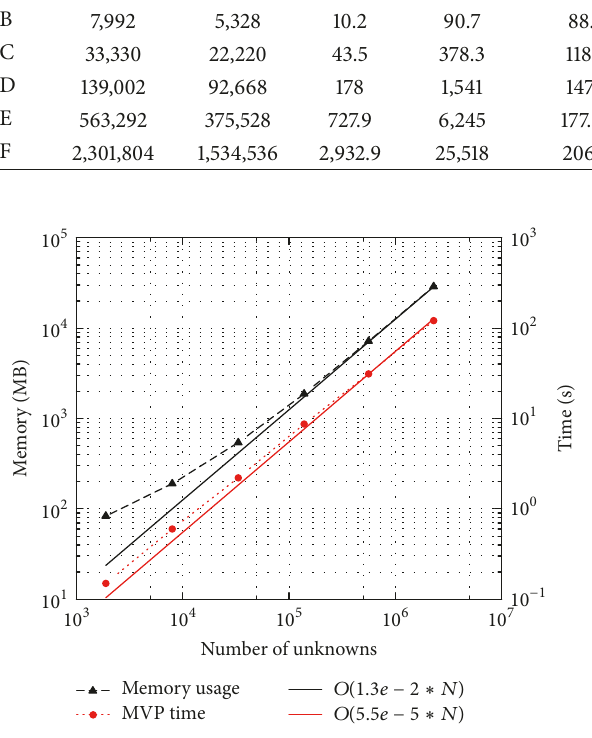
Figure 2: CPU time for each MVP and memory usage in the example of the PEC cube.